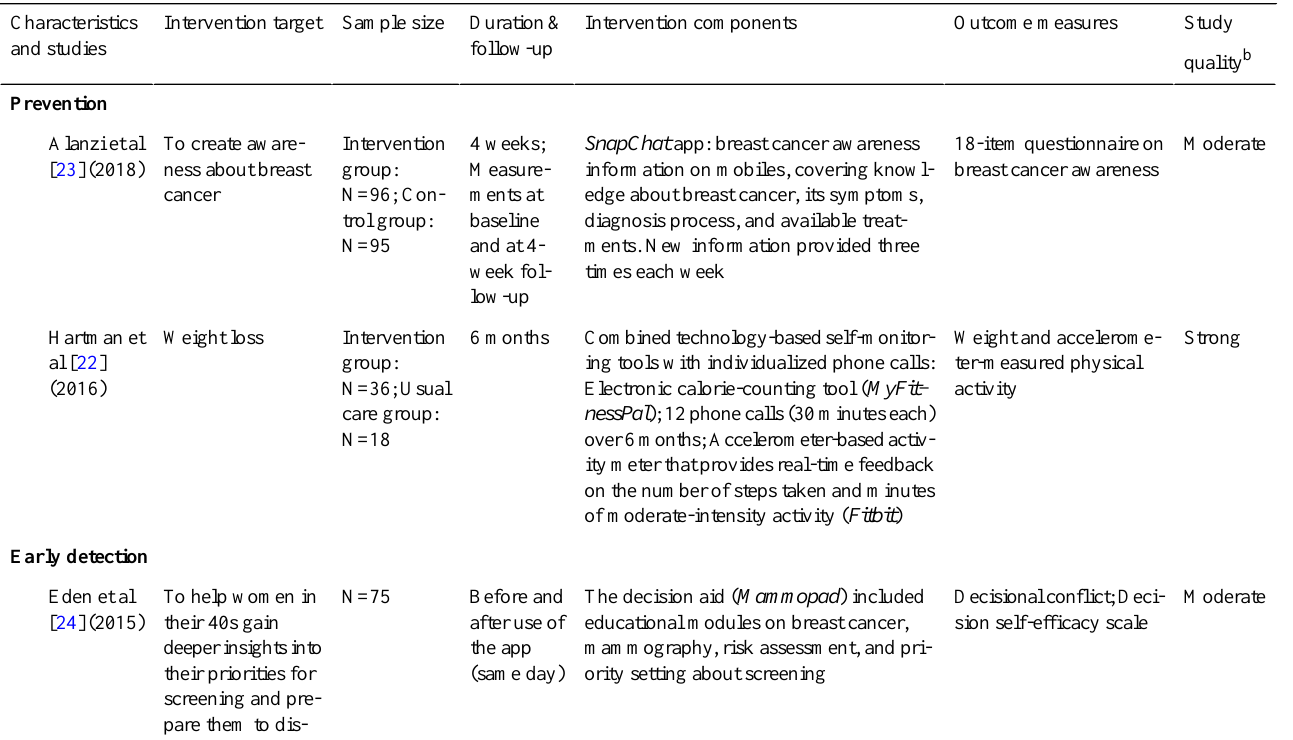
Table 1. Description of the characteristics of the studies presented in the review a